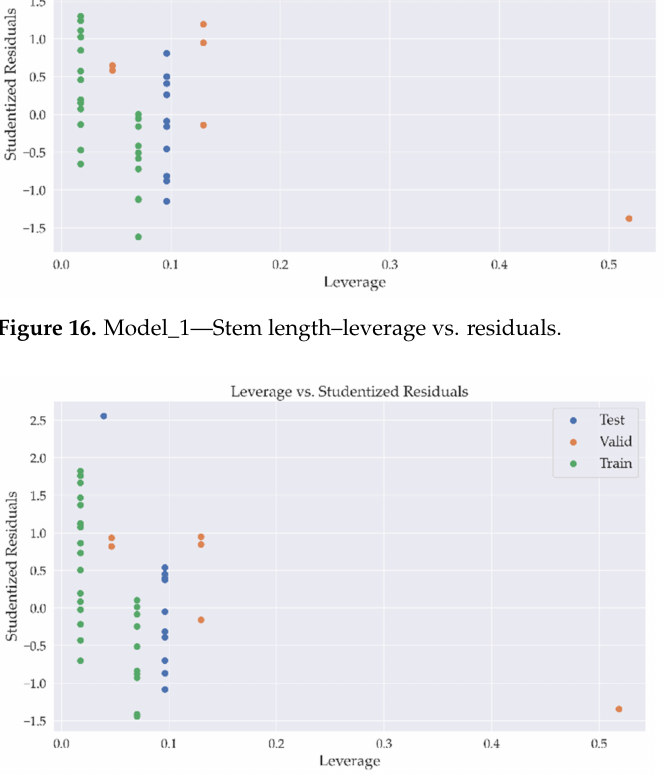
Figure 17. Model_2—Stem length–leverage vs.